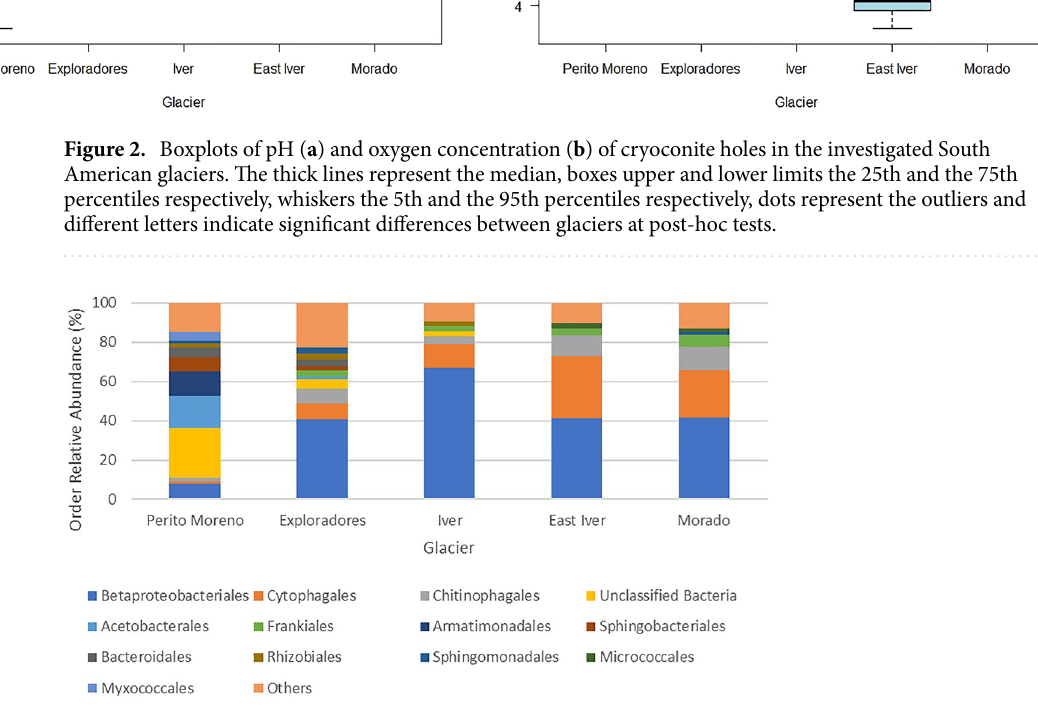
Figure 3. Barplot showing the relative abundance of the most abundant bacterial orders in the cryoconite holes on each glacier.